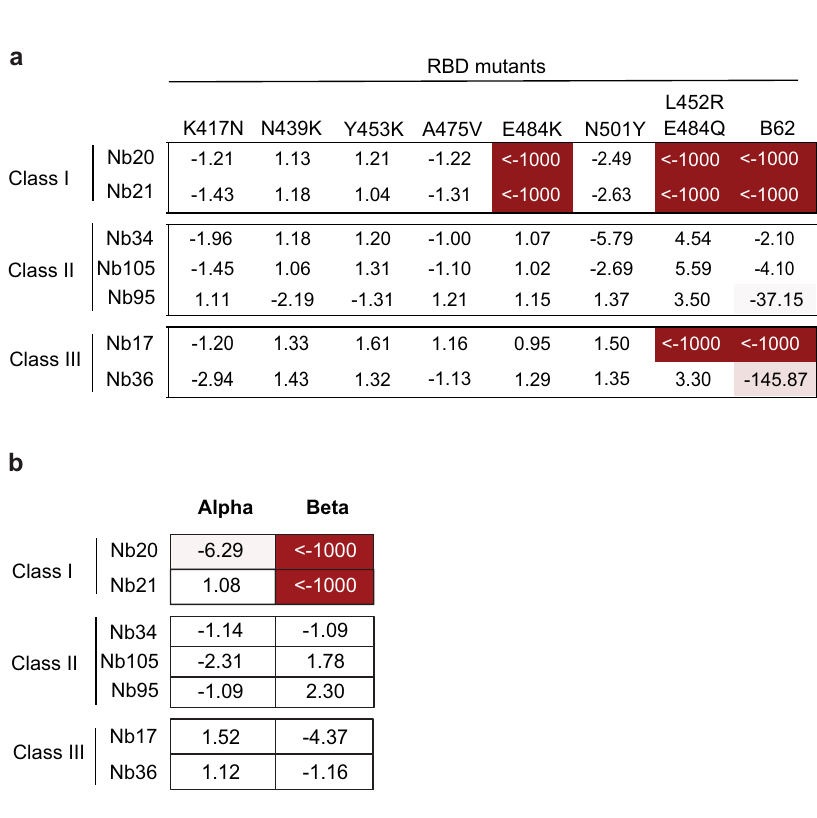
Fig. 1 The impact of RBD circulating variants on Nb binding and neutralization. a ELISA binding of the spike variants (a summary heatmap). Data are shown as binding af fi nity fold change relative to that of RBD WT. b The fold change in neutralizing potencies of the Nbs against two dominant circulating variants (Alpha and Beta strains) relative to that of the wild-type SARS-CoV-2 pseudovirus particles. Negative values represent a loss in af fi nity or neutralization potency, and positive values represent a gain in af fi nity or neutralization potency. Based on the highest Nb concentration tested, reduction in af fi nity or neutralization potency greater than 1000-fold is represented as “ < − 1000 ” .